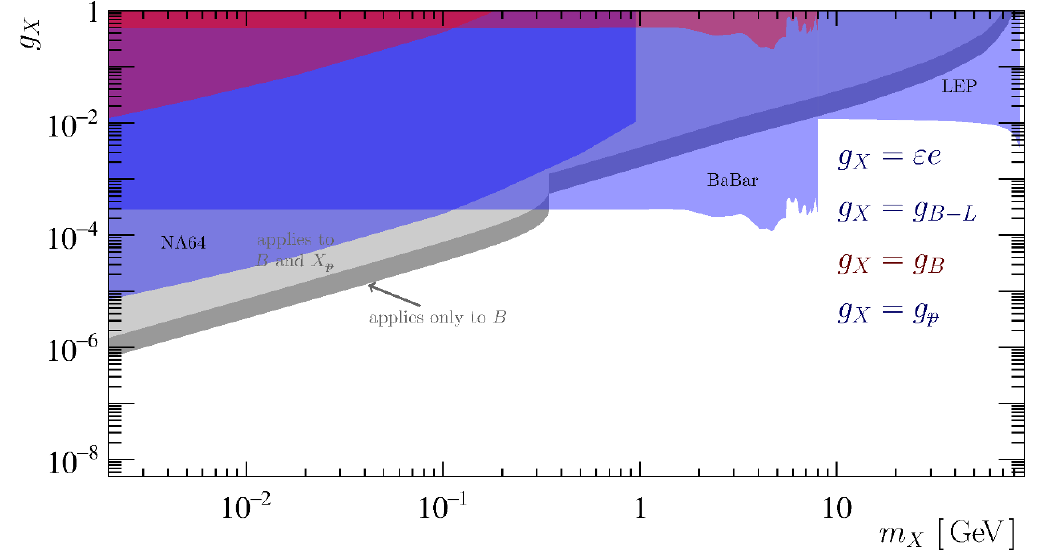
Figure 8 . Constraints on all models assuming longitudinally enhanced results of refs. [73, 74] for B , also recast here for the protophobic